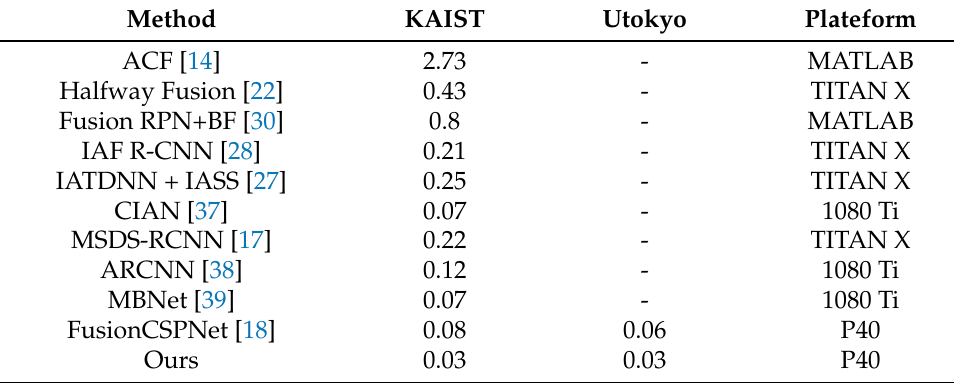
Figure 9. Qualitative comparison of multispectral pedestrian detection results in the Utokyo rea- sonable test subset with other state-of-the-art approaches. ( a ) ground truth, ( b ) detection results of YOLOv4 trained by color dataset only, ( c ) detection results of YOLOv4 trained by thermal dataset only, ( d ) detection results of FusionCSPNet trained by multispectral dataset, ( e ) detection results of ours method trained by multispectral dataset. Note that green bounding boxes (BBs) show GT labels, red and blue BBs are detection result, red BBs show TP, blue BBs show FP, and yellow shows FN. Best viewed in color. Table 3. Comparison of runtime with state-of-the-art